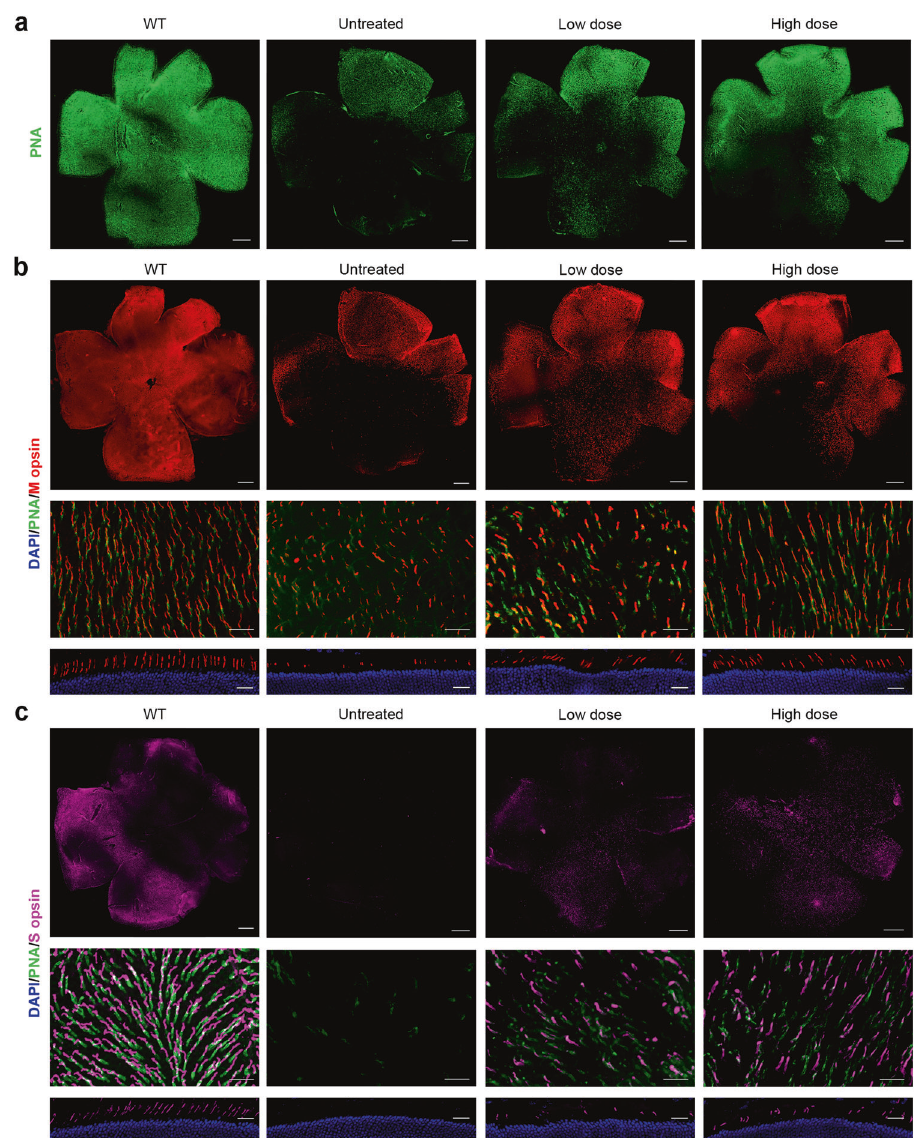
( b ) or S-opsin ( c ) antibody and PNA. DAPI, blue. Scale bars, 500 μ m for fl atmounts at low power; 25 μ m for fl atmounts at high power and eye cross